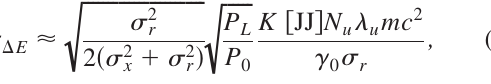
FIG. 4. (Color) An example of the heater laser temporal profile measured on a streak camera. The laser FWHM pulse duration is about 20 ps, and the high-frequency temporal structures are due to the measurement noise.